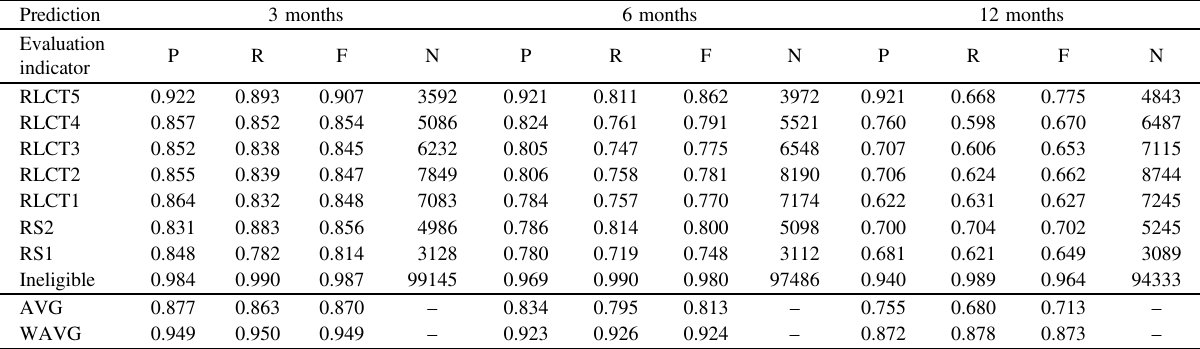
Table 4 Future eligibility level prediction based on multiclass classi fi cation and GBDT.